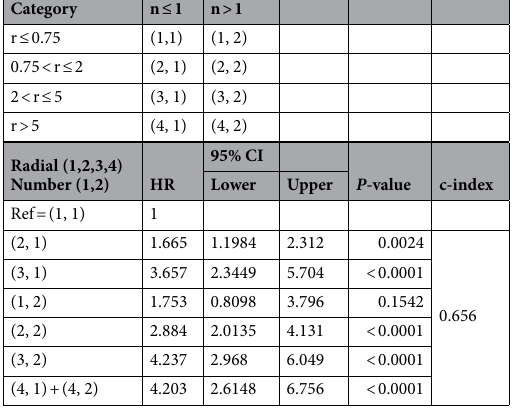
Table 3. Cox regression analysis of BCR using radial distance 0.75 mm and number of EPE combinations. n: number of EPE, r: radial distance of EPE (mm).